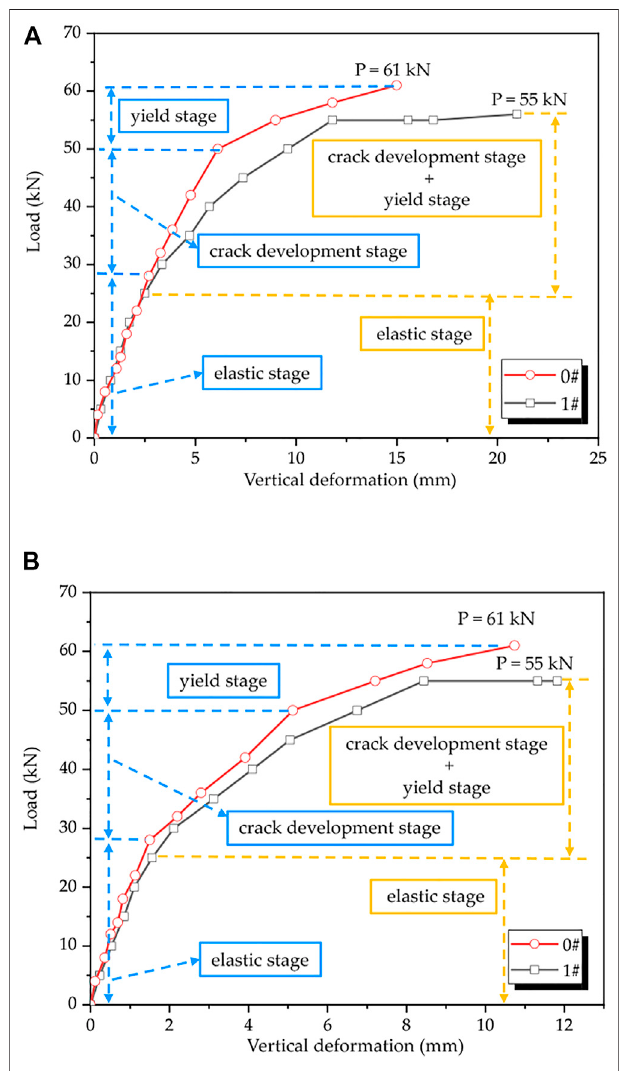
FIGURE 10 | Load-de fl ection curve of typical sections: (A) section 3L/4 and (B) section L/4.